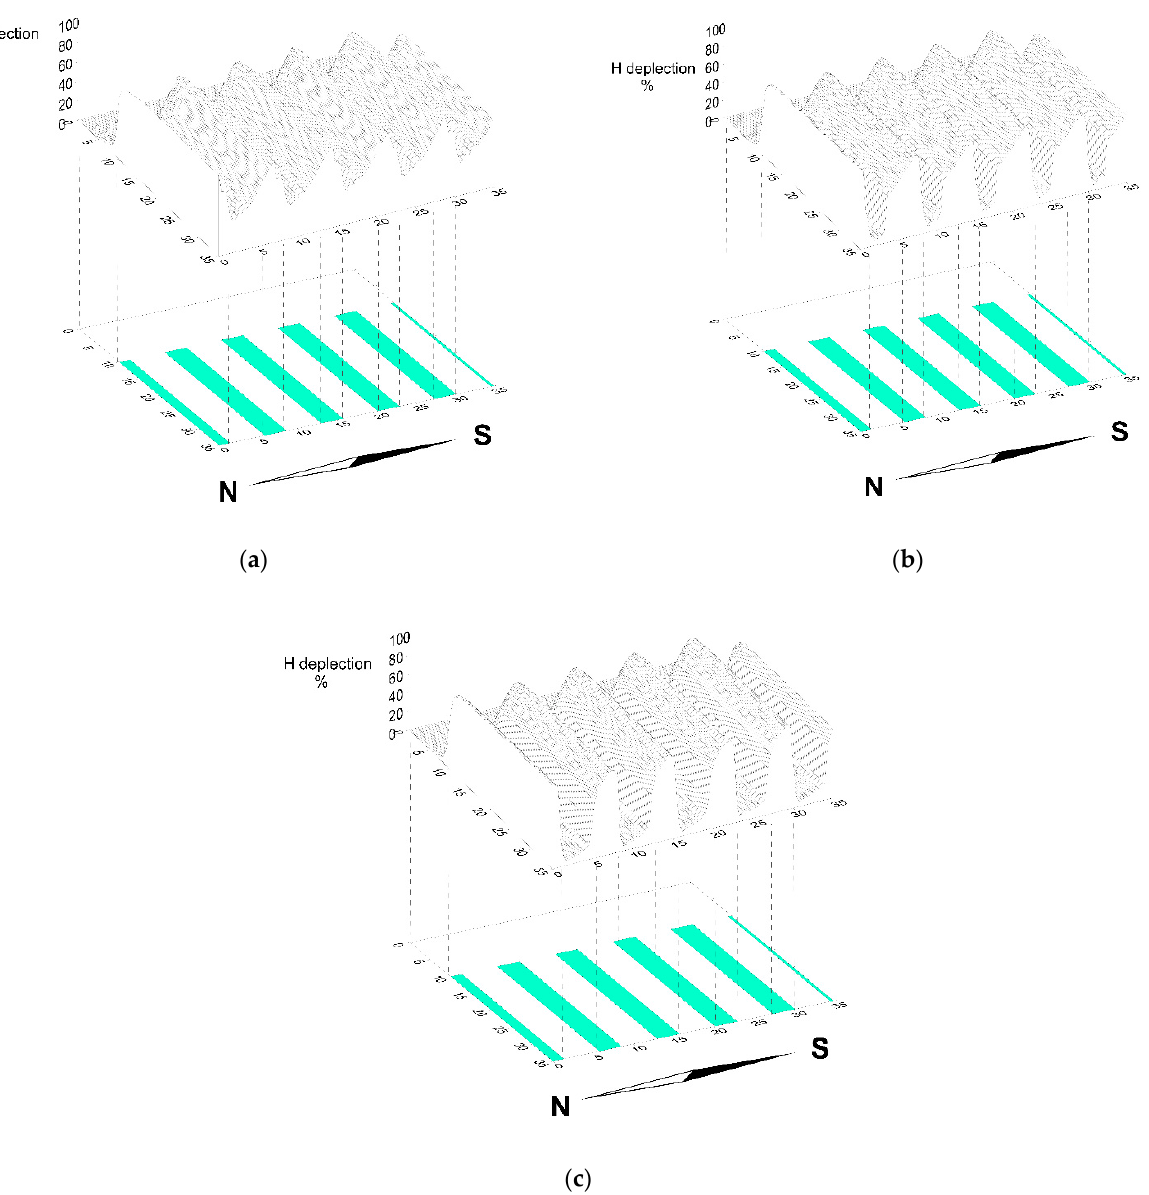
Figure 9. Representation of solar irradiance reduction on agrivoltaic plant in comparison to a traditional crop without PV panels at the “Alcolea 1” installation on a synoptic day of ( a ) December, ( b ) March, ( c ) June.